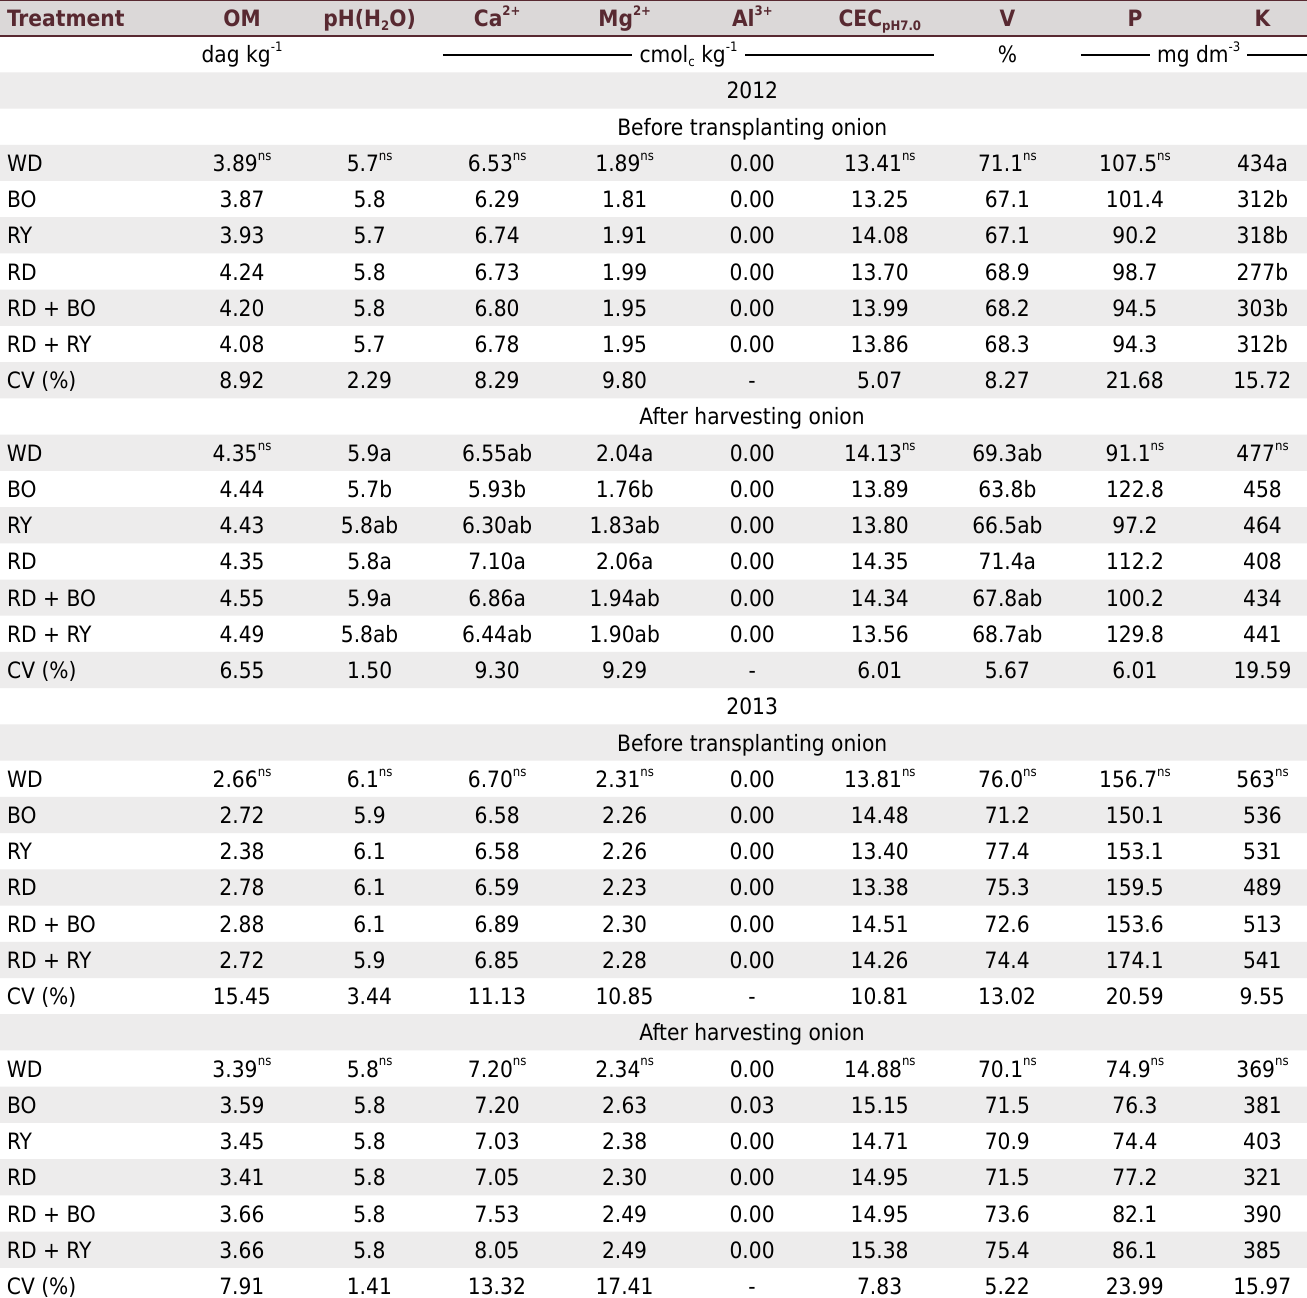
Table 5. Organic matter content (OM), pH in water, exchangeable calcium, magnesium and aluminum, available potassium and phosphorus, and CEC pH7.0 and base saturation (V) in the 0.00-0.10 m layer of an Inceptisol cropped to onion, in the presence